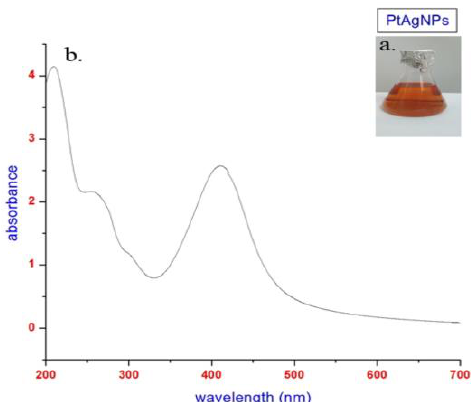
Figure 2. ( a ) Color change of PTAgNPs. ( b ) UV – Vis spectrum of PTAgNPs measuring absorbance at 415 nm.